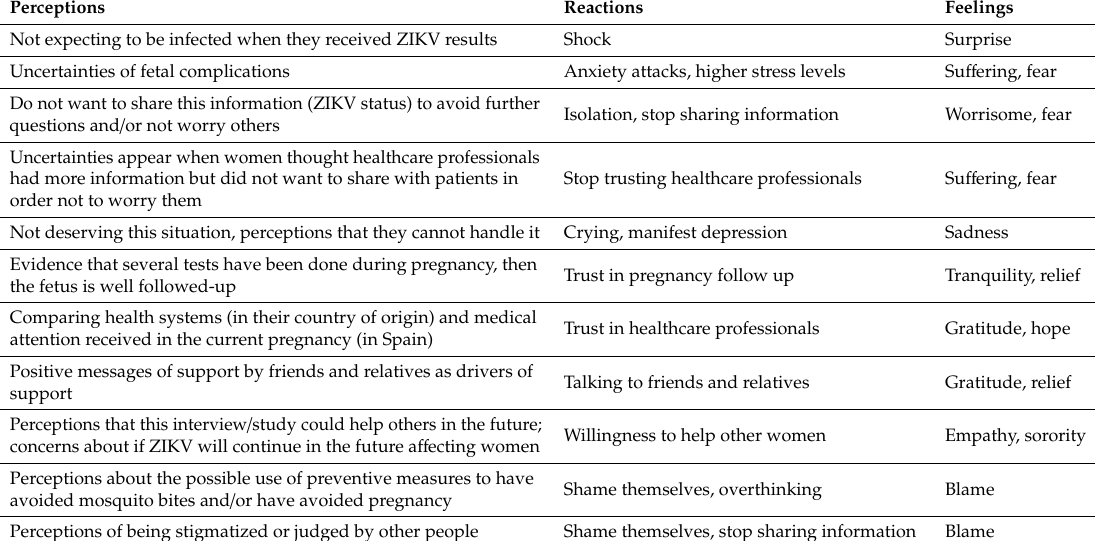
Perceptions, reactions and feelings expressed by women with diagnosis of ZIKV during